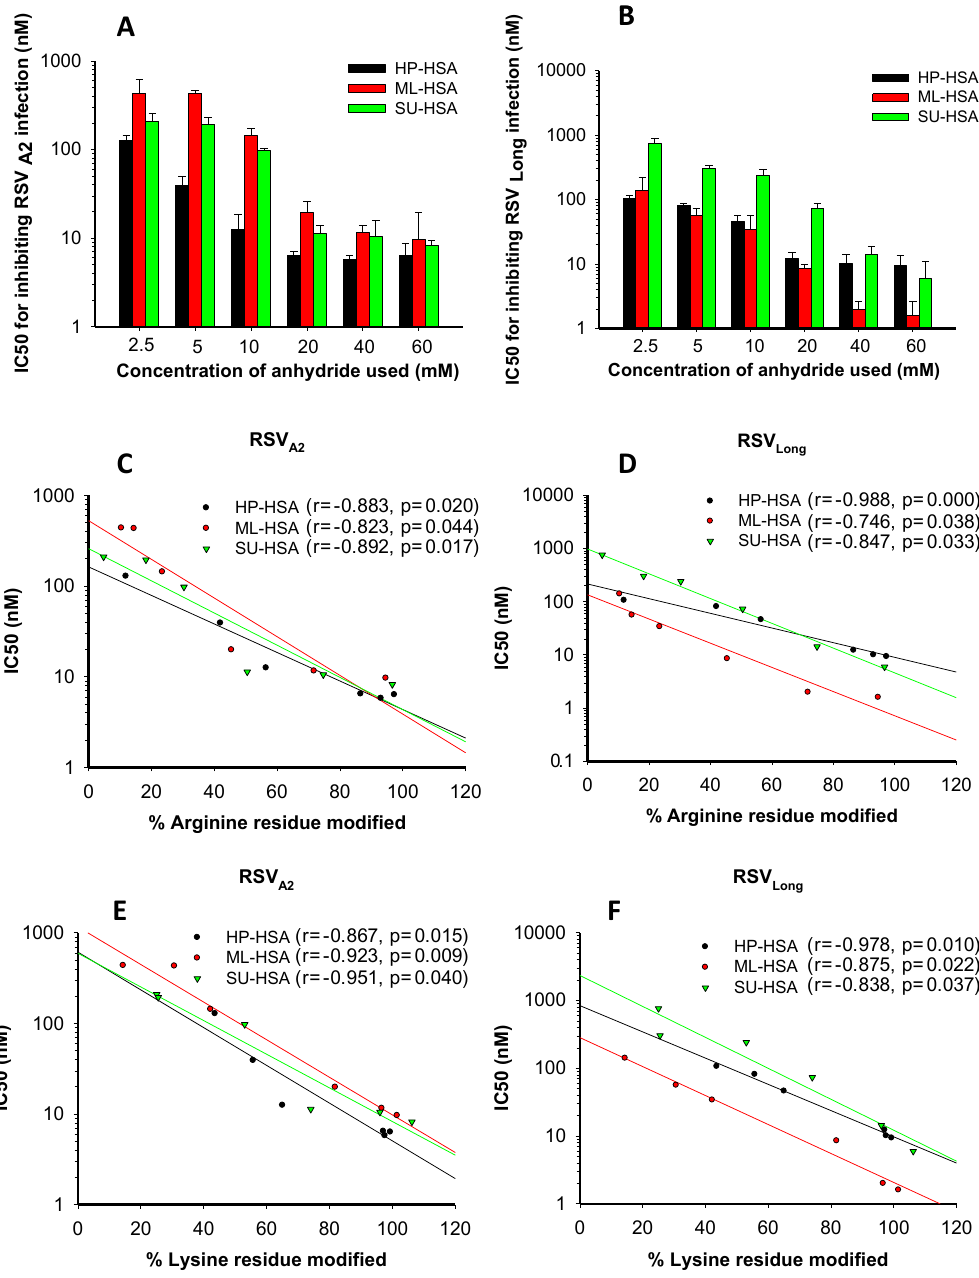
Figure 1. The effects of anhydride concentrations in the reaction system on anti-RSV activity of the HP-, ML-, and SU-modified human serum albumin (HSA) and the correlation between the percentages of modified residues and anti-RSV activity of the modified HSA. The IC 50 values of HSA modified with HP, ML, and SU, respectively, for inhibiting infection by RSV A2 Strain ( A ) and Long Strain ( B ). The correlation between the percentages of the modified arginine residues and the antiviral activities of the modified HSA against RSV A2 Strain ( C ) and Long Strain ( D ). The correlation between the percentages of lysine residues and the antiviral activities of the modified HSA against RSV A2 strain ( E ) and Long Strain ( F ). Each sample was tested in triplicate, and the experiment was repeated twice. The data from one representative experiment were presented in mean ±